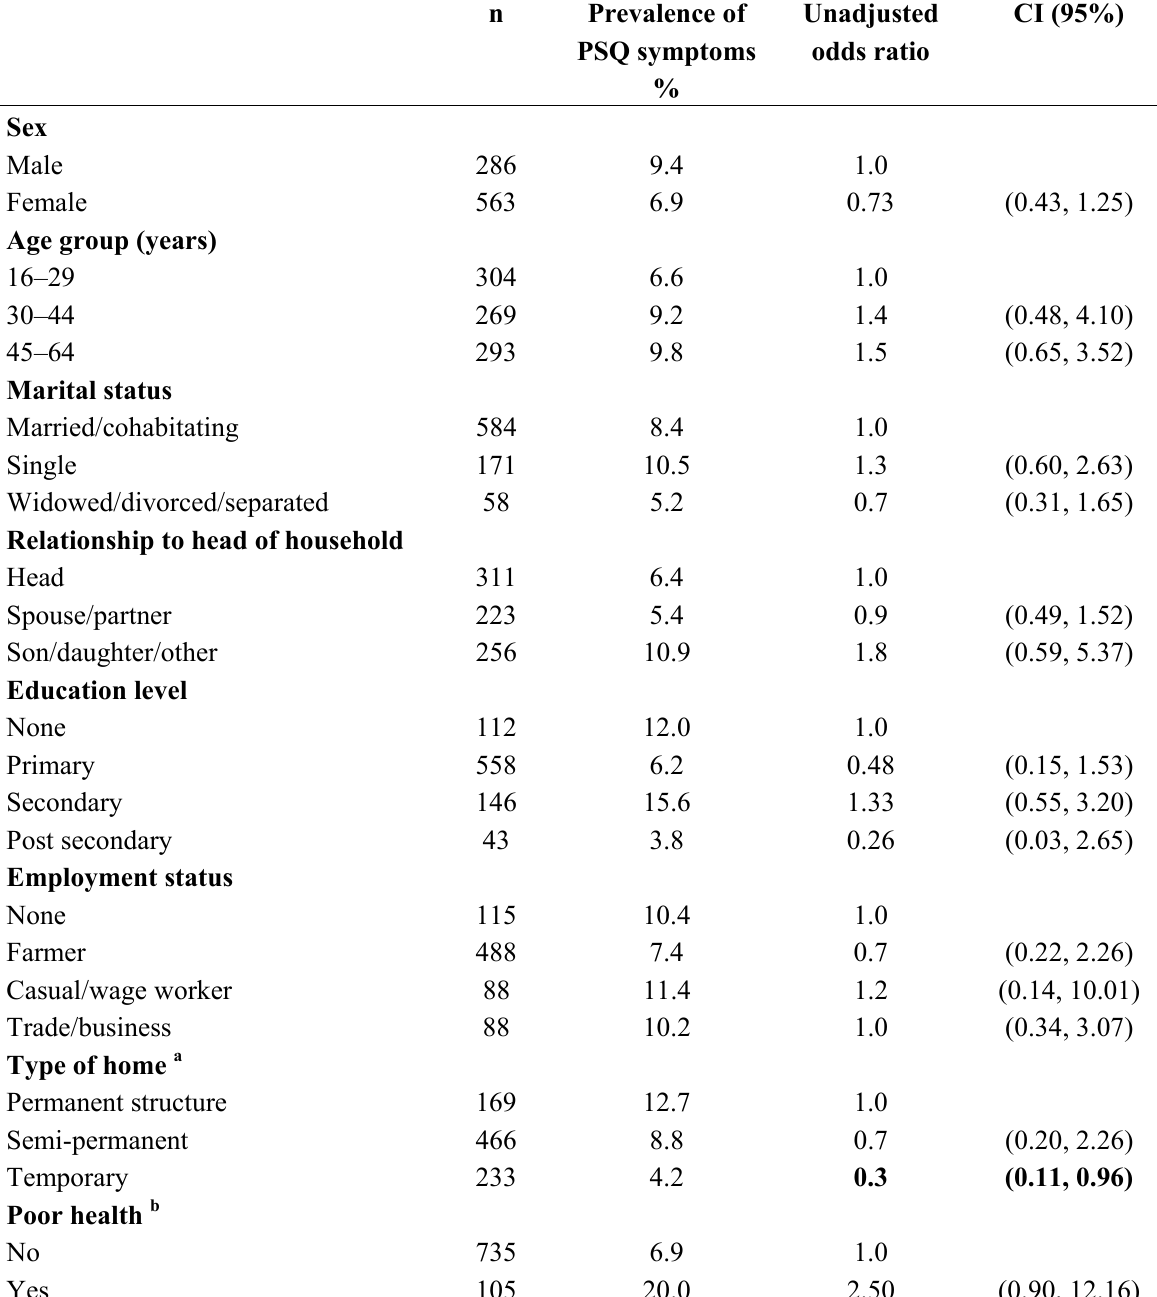
Table 3. Prevalence rates and unadjusted odds ratios of any psychotic symptoms in relation to background